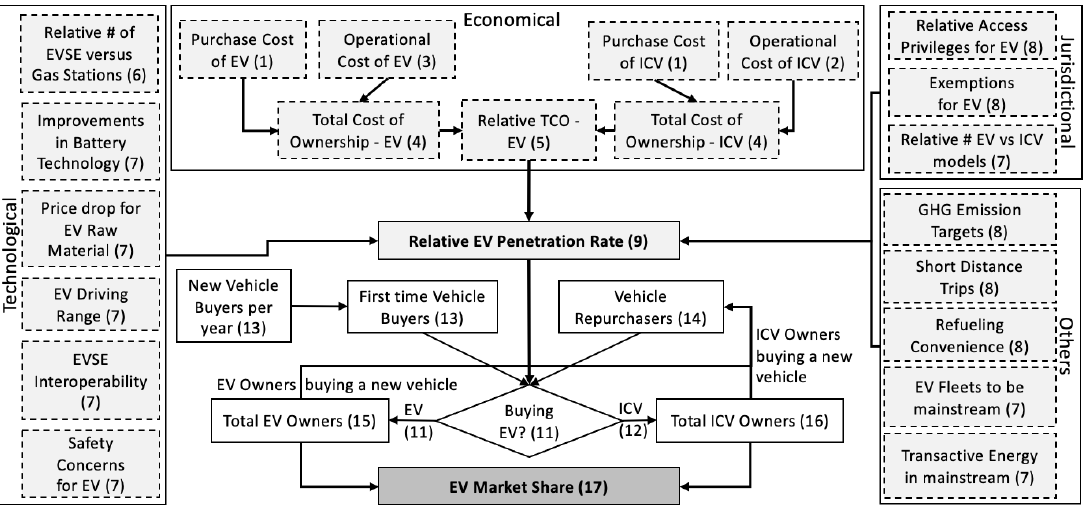
Figure 1. Logical model view depicting REVPR and EVMS calculations using EV proliferation factors.